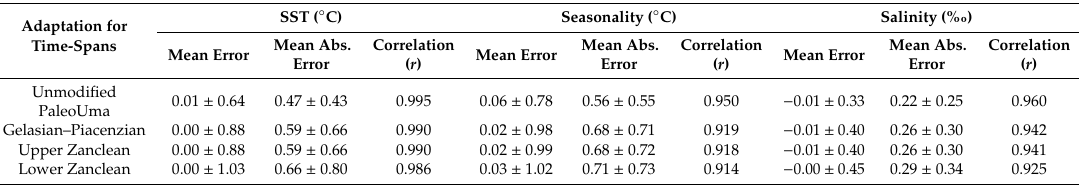
Table 2. Statistics resulting of the tests of behavior of PaleoUma database adapted to di ff erent time-spans of the Gelasian–Pliocene.